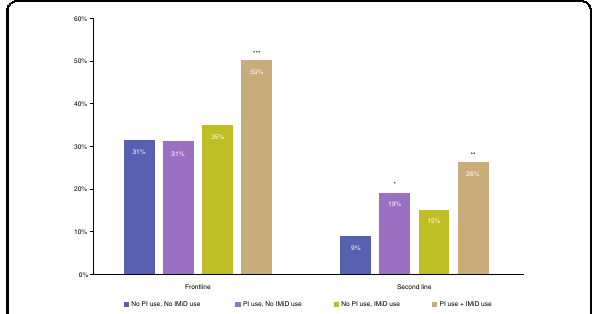
Fig. 1 Complete renal response (CRR) by combined proteasome inhibitor (PI) use and immunomodulatory drug (IMiD) use in frontline and second line. Logistic regression models were used to examine the association between treatment class (i.e., PI and IMiD) and CRR status adjusted for other treatment classes received, age, sex, race, practice type, year of therapy line, and cytogenetic risk. * P < 0.05, ** P < 0.01, *** P < 0.001 vs no PI or IMiD use from multivariable